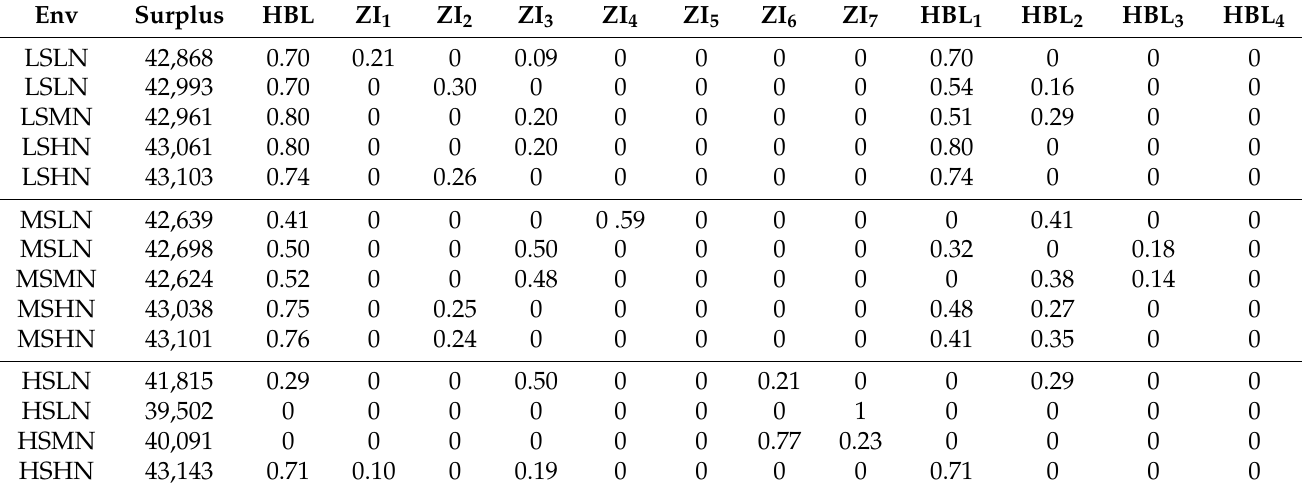
Table A8. Equilibria for games with spoofing, N = 65, calculated from the five-player DPR approximation. Each row of the table describes one equilibrium found with its corresponding surplus, HBL adoption rate and the equilibrium mixture probabilities of strategies included.